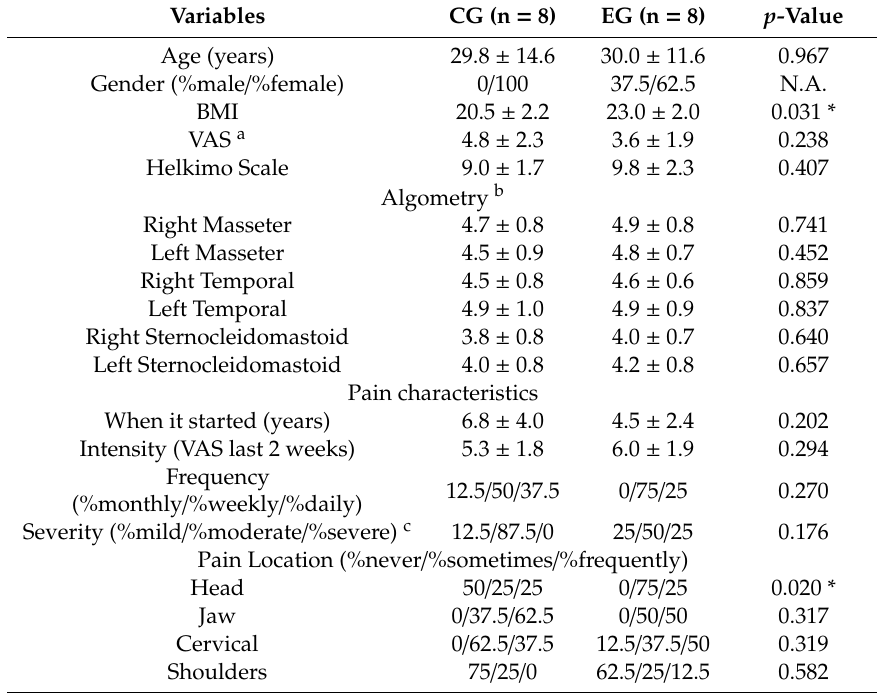
Table 2. Participants’ Demographic and Baseline Clinical